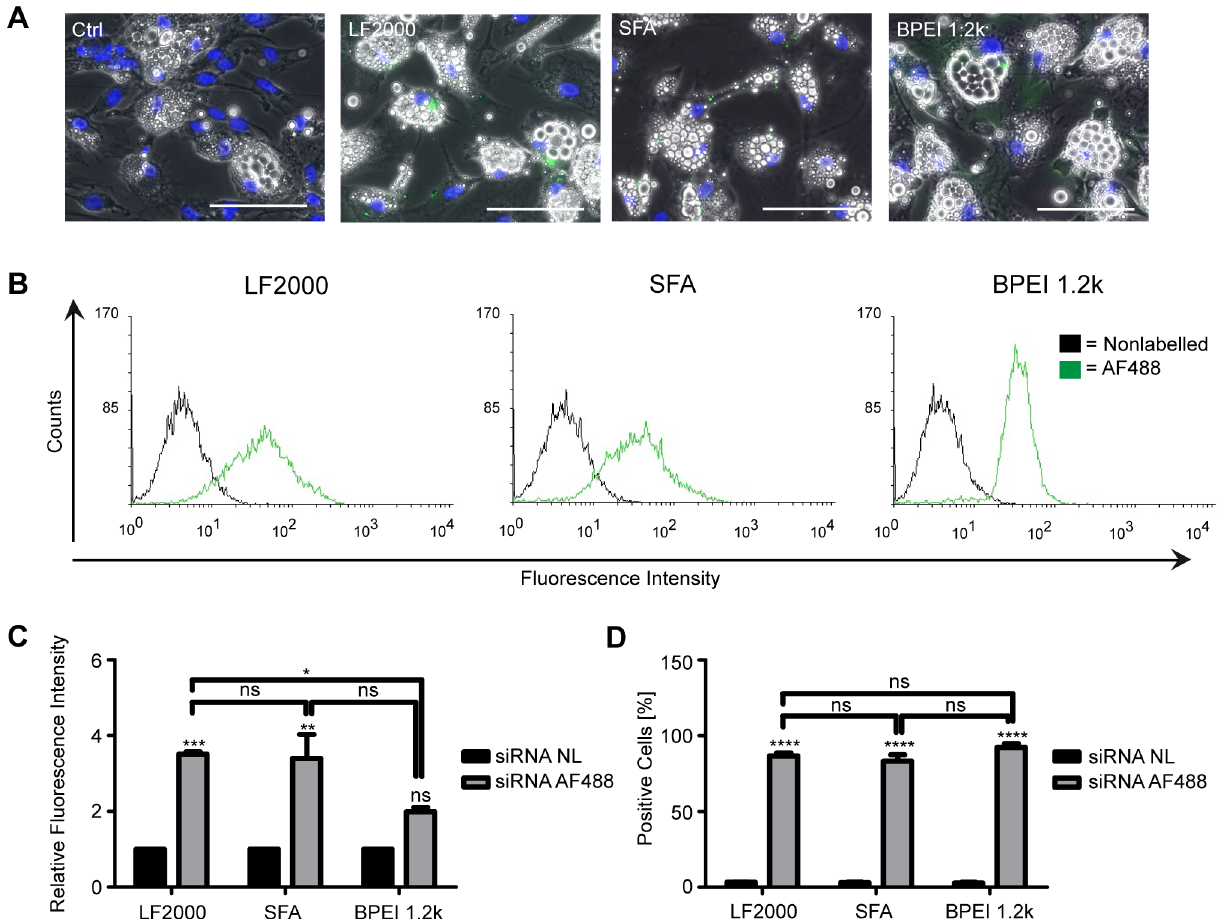
Figure 2. siRNA transfection of SGBS adipocytes. Cells were transfected with a non-labelled and an Alexa Fluor 488 (green) labelled, nonspecific siRNA using Lipofectamine 2000 (LF2000), ScreenFect A (SFA) and BPEI 1.2 k as delivery agents. Uptake of the labelled siRNA was assayed 48 hours post-transfection with fluorescence microscopy and flow cytometry. Fluorescent overlay micrographs (A) of paraformaldehyde-fixed cells taken with a 20x objective. Nuclei were counterstained with DAPI (blue). Scale bars are 100 m m. Pictures from one representative experiment out of two performed are shown. Histogram overlays (B), relative fluorescence intensities (C) and transfection efficiencies (D) from the flow cytometric analysis of the siRNA AF488 transfected cells. Data are expressed as mean and SEM of three independent triplicate experiments. ***p , 0.0009 LF2000 nonlabelled vs. labelled, **p , 0.0014 SFA nonlabelled vs. labelled and *p , 0.0382 LF2000 vs. BPEI in (C) and ****p , 0.0001 nonlabelled vs. labelled in